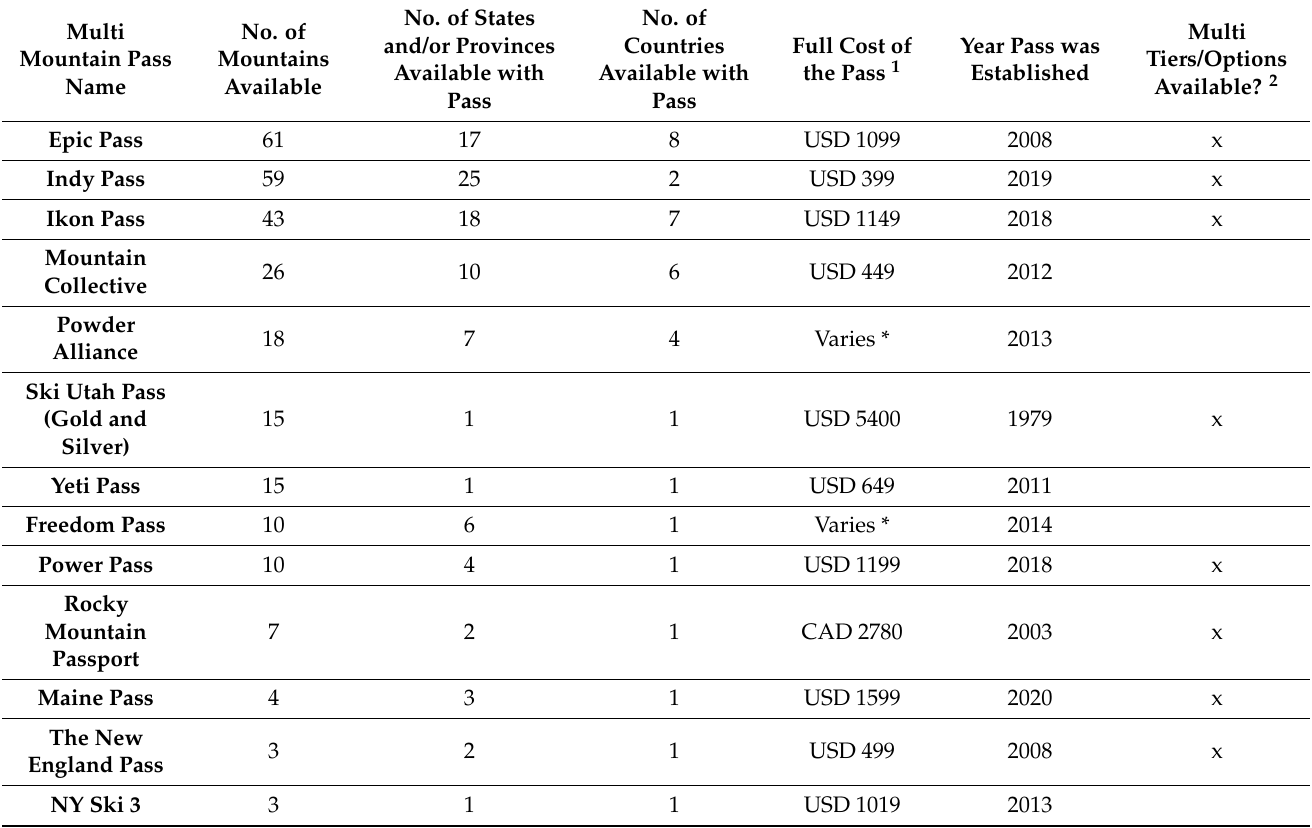
Table 3. Multi-mountain ski passes—North America